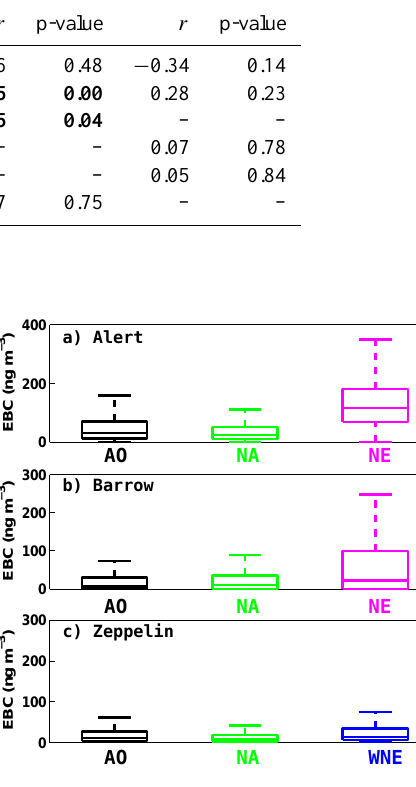
Fig. 12. Box-whisker plots of the EBC concentrations associated with each cluster at Alert (a) , Barrow (b) , and Zeppelin (c) , where the box boundaries mark the 25th and 75th percentile of the data and the whiskers includes 99% of the